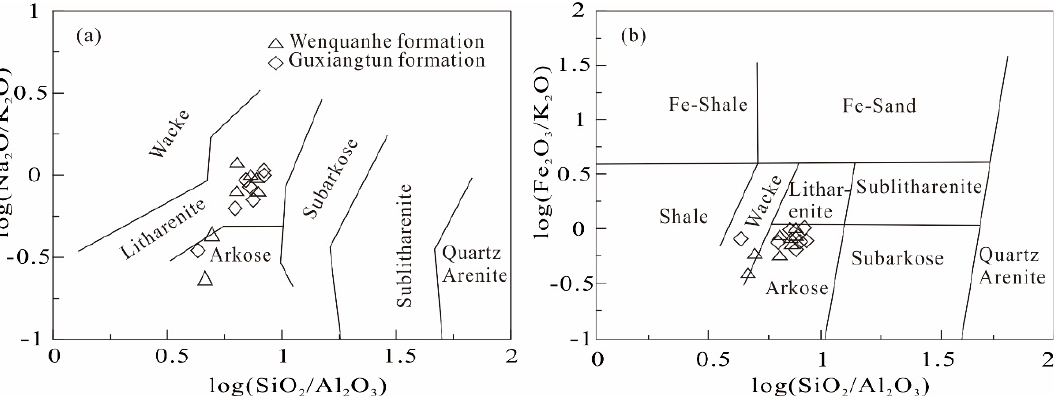
Figure 4. ( a , b ) Geochemical classified graph for the sediments from the Songhua River after Herron [29].